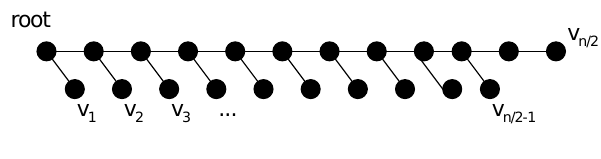
Fig. 3: Lower bound